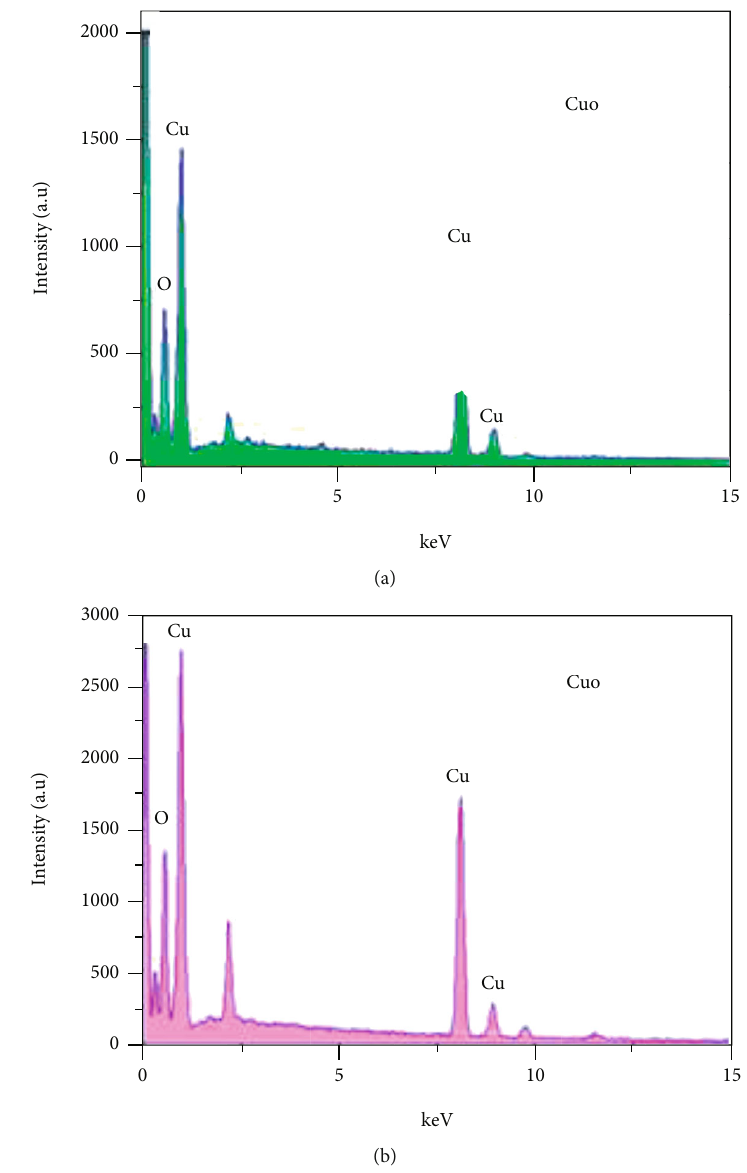
Figure 5: EDX images of (a) CuO and (b) CuO/PVA